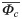
The 95th percentile of ns against Φc¯ for the values of k between 11 and 101.Note that the y-axis is logarithmic. The solid black line indicates the calculated random chance’s value of n based on F11. The blue dots represent random chance, the green diamonds represent minimal information, and the red triangles represent maximal information.